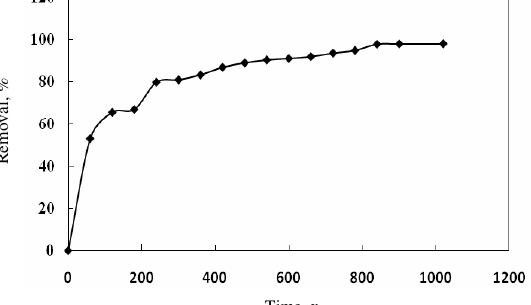
Figure 3. Effect of contact time (S) on CR removal by 0.025 g of Pt NP-AC in 50 mL, pH